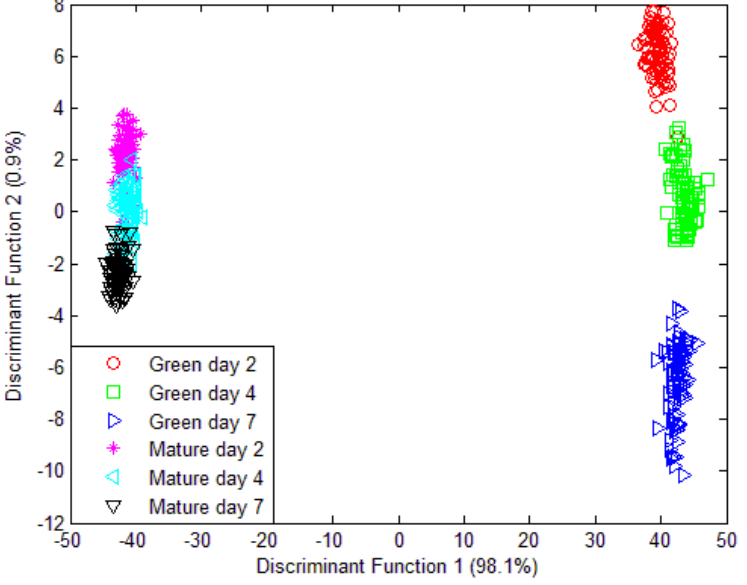
Table 8. Classification results a,b on the fused e-nose and acoustic sensor using LDA for three different maturity and ripeness levels of Harumanis harvested on two different dates (week 7 and week